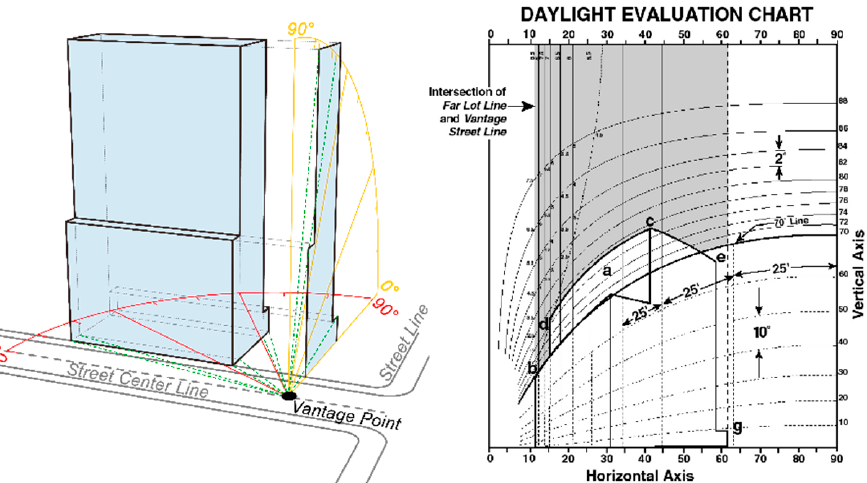
Figure 2. Example of height control regulation according to street width: N.Y.C. Daylight Evaluation Chart (D.E.C.).